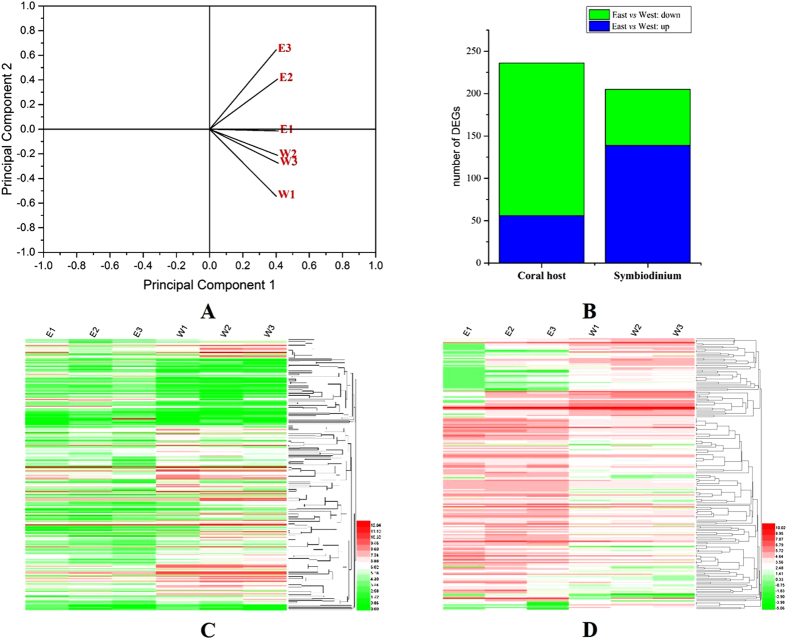
(A) Principal component analysis based on the expression level data of the G. fascicularis symbioses transcriptome from six sites. Gene expression was computed as FPKM with a pseudocount of 0.01. Principal component analysis was performed in Origin Pro 9.1. The first two principal components explained 95.45% of the total variance. (B) Overview of the number of differentially expressed genes. The differentially expressed genes of the G. fascicularis host and its endosymbiont Symbiodinium were identified by comparing the east and west transcriptome with |log2 fold change| > 1.0 and FDR adjusted p-values ≤ 0.05. Heatmap analysis of differentially expressed genes identified in the G. fascicularis host (C) and its endosymbiont Symbiodinium (D). The heatmap was created using heatmap2 in the R statistical computing environment, and the gene expression was characterized as the log2 of the ratio between expression levels in the 6 sites. Higher expression levels are shown in pink, while lower expression levels are shown in green. (E1, E2 and E3: sampling sites in the east pool. W1, W2 and W3: sampling sites in the west pool).